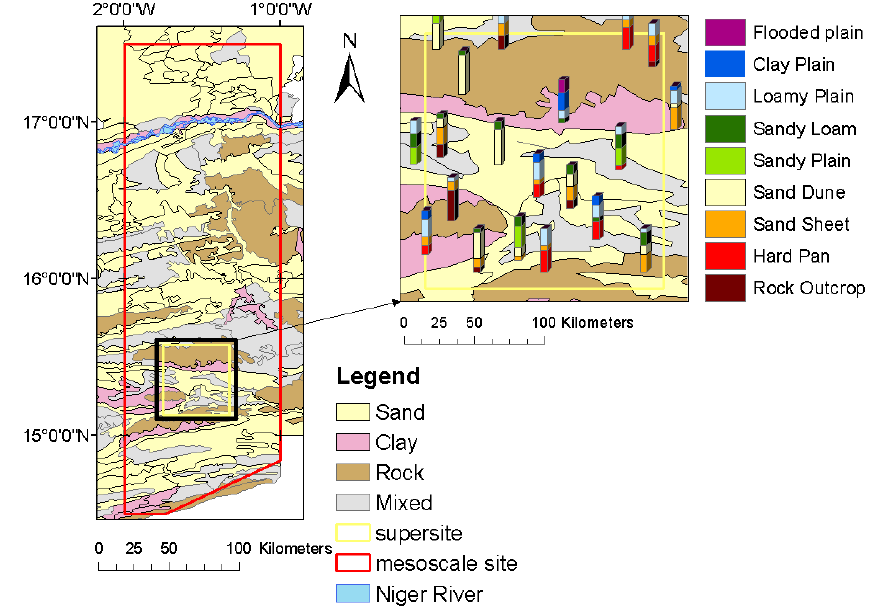
Fig. 4: Soil types map of the AMMA meso-scale site in Mali. The 9 soil types (stacked bars) are grouped into 4 dominant soil texture classes (polygons)